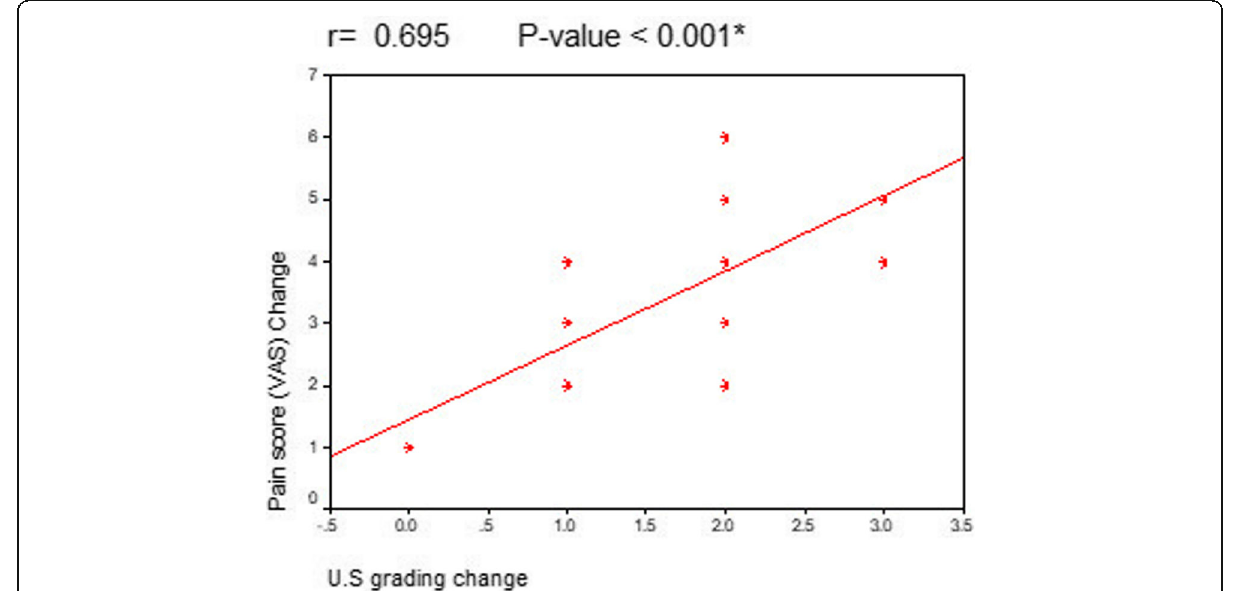
Fig. 3 Correlation between US grading change and VAS